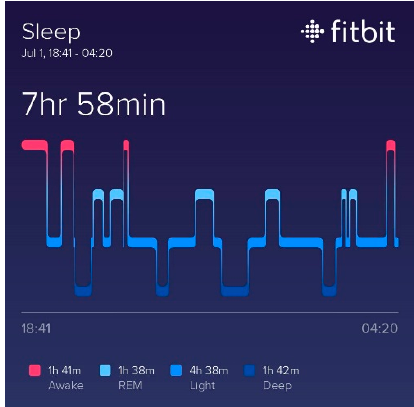
Figure A15. Copenhagen,